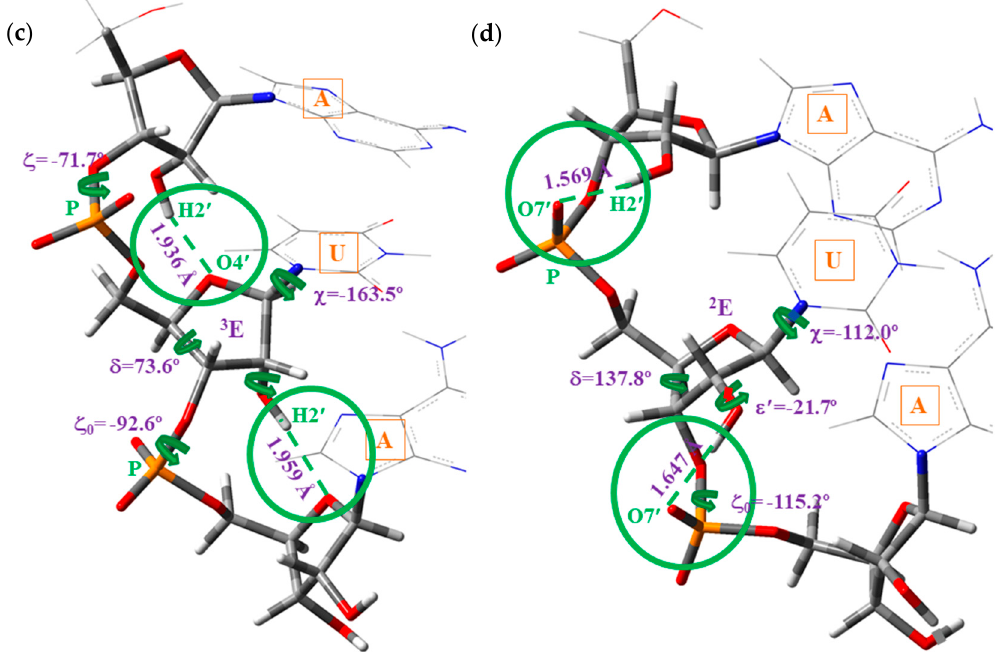
Scheme 3. DNA:RNA microhelixes types A and B according to the intermolecular H-bonds in strand